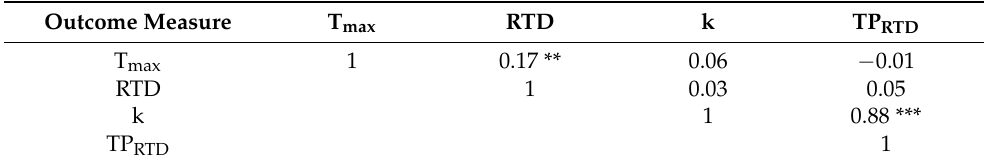
T max -maximal isometric torque; RTD-rate of torque development; k-slope of regression line (rate of force development scaling factor); TP RTD -theoretical peak of RTD; *** p < 0.001. Table 4. Result of Spearman’s rank correlation